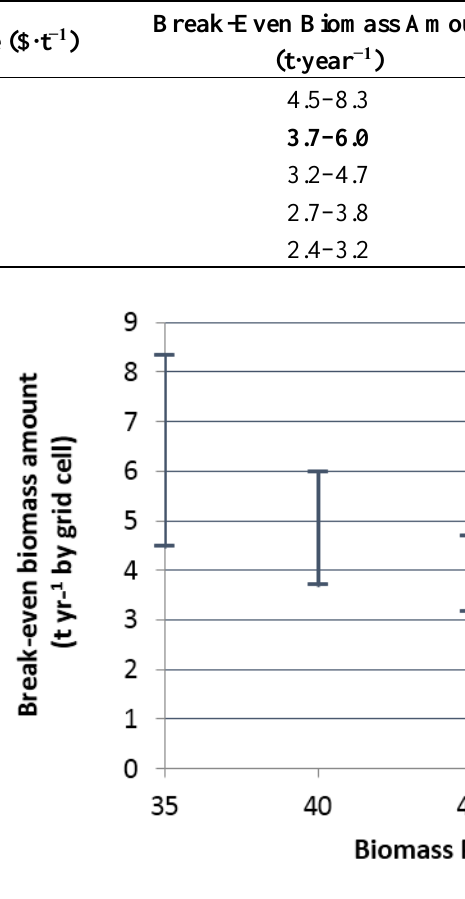
Figure 5. Ranges of break-even biomass amount at different biomass